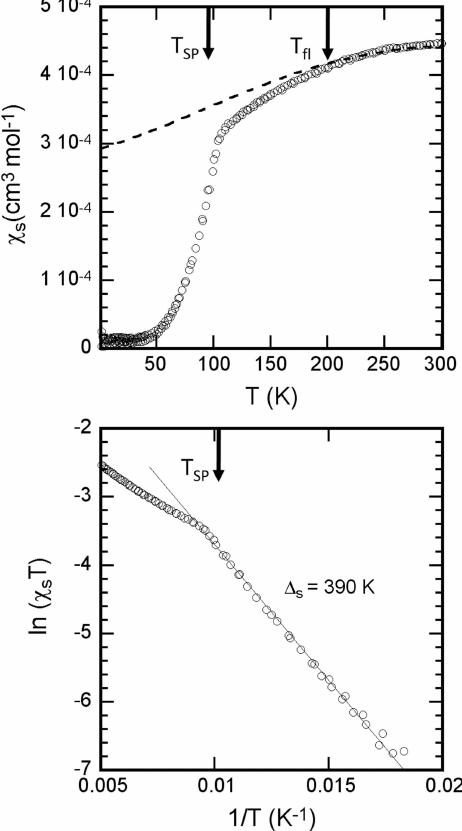
Figure 5 ( a ) Temperature dependence of the spin susceptibility, (cid:10) s , in ( o -Me 2 TTF) 2 NO 3 . A Curie tail encompassing 0.65% S = 1 defaults has been subtracted. The dotted line is an HT fit to the uniform AF Heisenberg chain. ( b ) Plot of ln( (cid:10) s T ) versus 1/ T , allowing the spin 1 2 determination of the spin activation energy (cid:2) (cid:2) ’ 390 K in the spin- Peierls ground